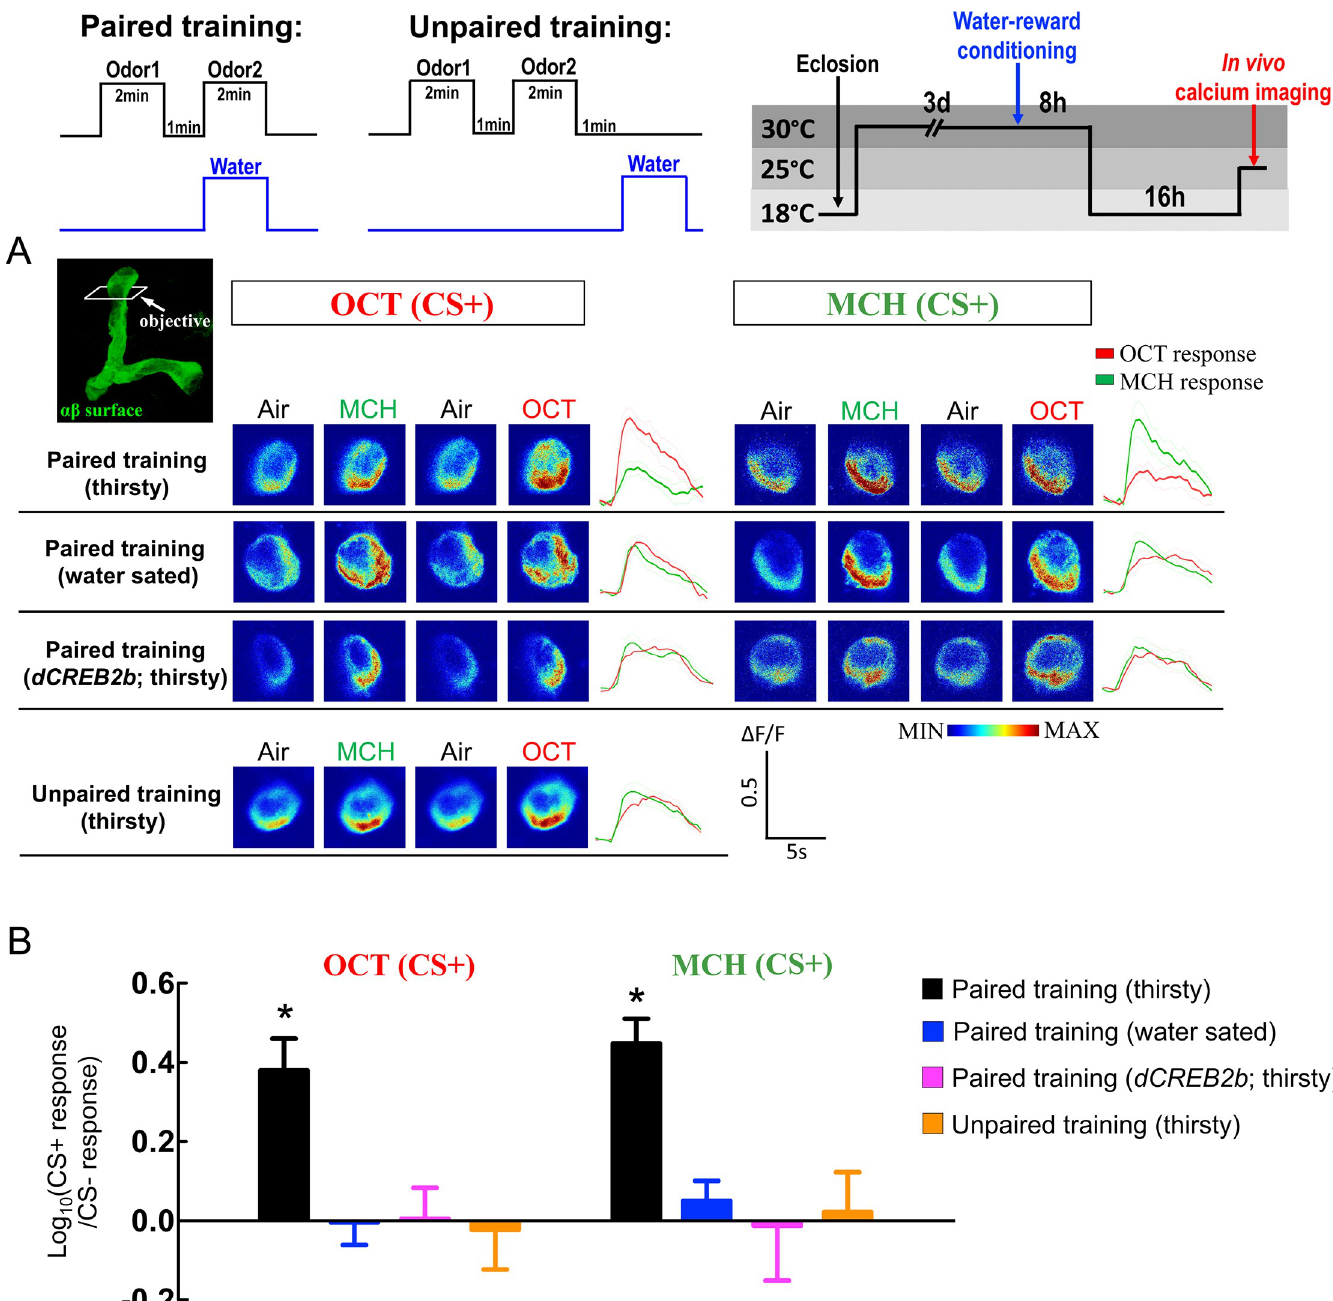
Fig 6. αβ surface neurons show a CREB2-dependent increased cellular calcium response to training odor at 24-hour post-conditioning. Top diagram illustrating the protocols of paired training, unpaired training, and in vivo calcium imaging. (A) The GCaMP6 response 24-hour after water-reward conditioning was assayed in αβ surface neurons (the image-recording region is showed in the top left figure). For the paired training group: flies received CS − odor without water-reward (US), followed by exposure to the CS+ odor with water-reward. For the unpaired training group: flies received CS − odor without water-reward, followed by exposure to CS+ odor without water-reward, and water-reward was delivered 1-minute after CS+ odor. Odor/water paired training induced additional increment of GCaMP6 responses in the α -lobe region of αβ surface neurons to the training odor [OCT-trained flies: OCT (CS+), MCH-trained flies: MCH (CS+)] in thirsty-state. This additional increased calcium response was abolished in water-sated state (flies allowed to drink water for 30 minutes before in vivo calcium imaging recording) or in thirsty flies with dCREB2b expression in αβ surface neurons. (B) Quantification of the GCaMP6 responses to the training odor (CS+) relative to the non-training odor (CS − ) in the α - lobe region of αβ surface neurons in OCT-trained (left panel) or MCH-trained (right panel) flies at 24-hour post-conditioning. The Log ratios of the CS+ response to the CS − response were calculated using the peak response amplitudes. Each value represents mean ± SEM (N = 8~12). � , p < 0.05; significantly different from zero; one sample t-test. Genotype: (1) Flies carrying UAS-GCaMP6m/tub-GAL80 ts ;VT20803-GAL4 /+ transgenes were used for Paired training (thirsty), Paired training (water